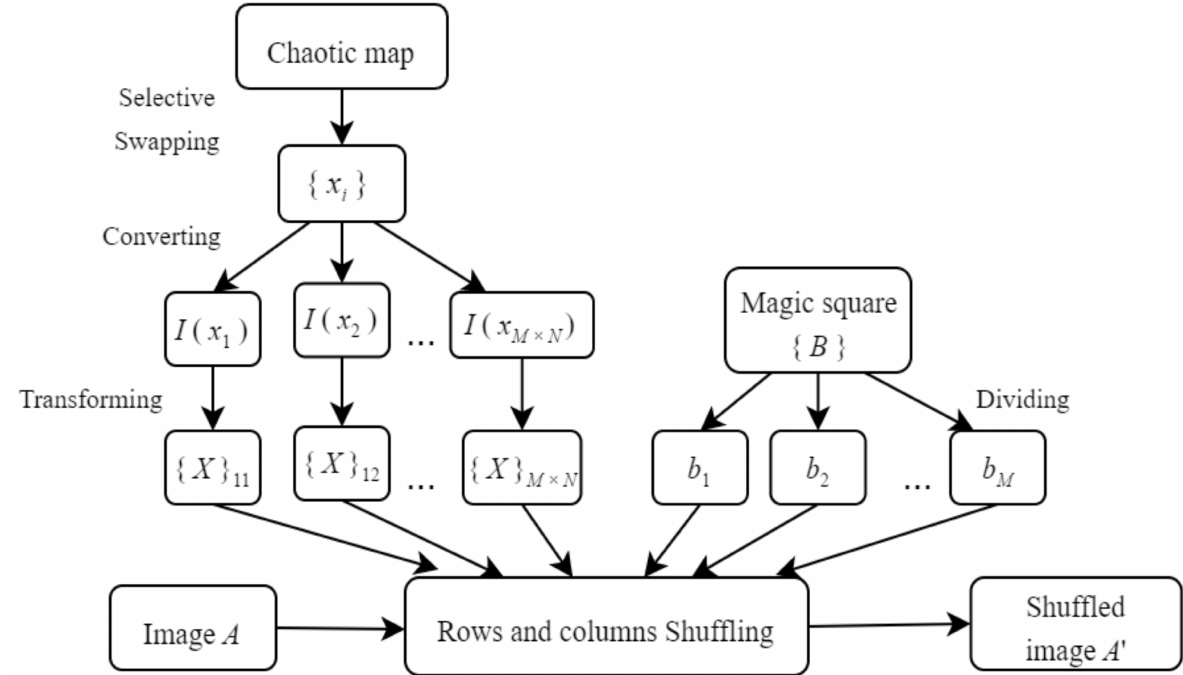
Figure 10. The flowchart of the shuffling